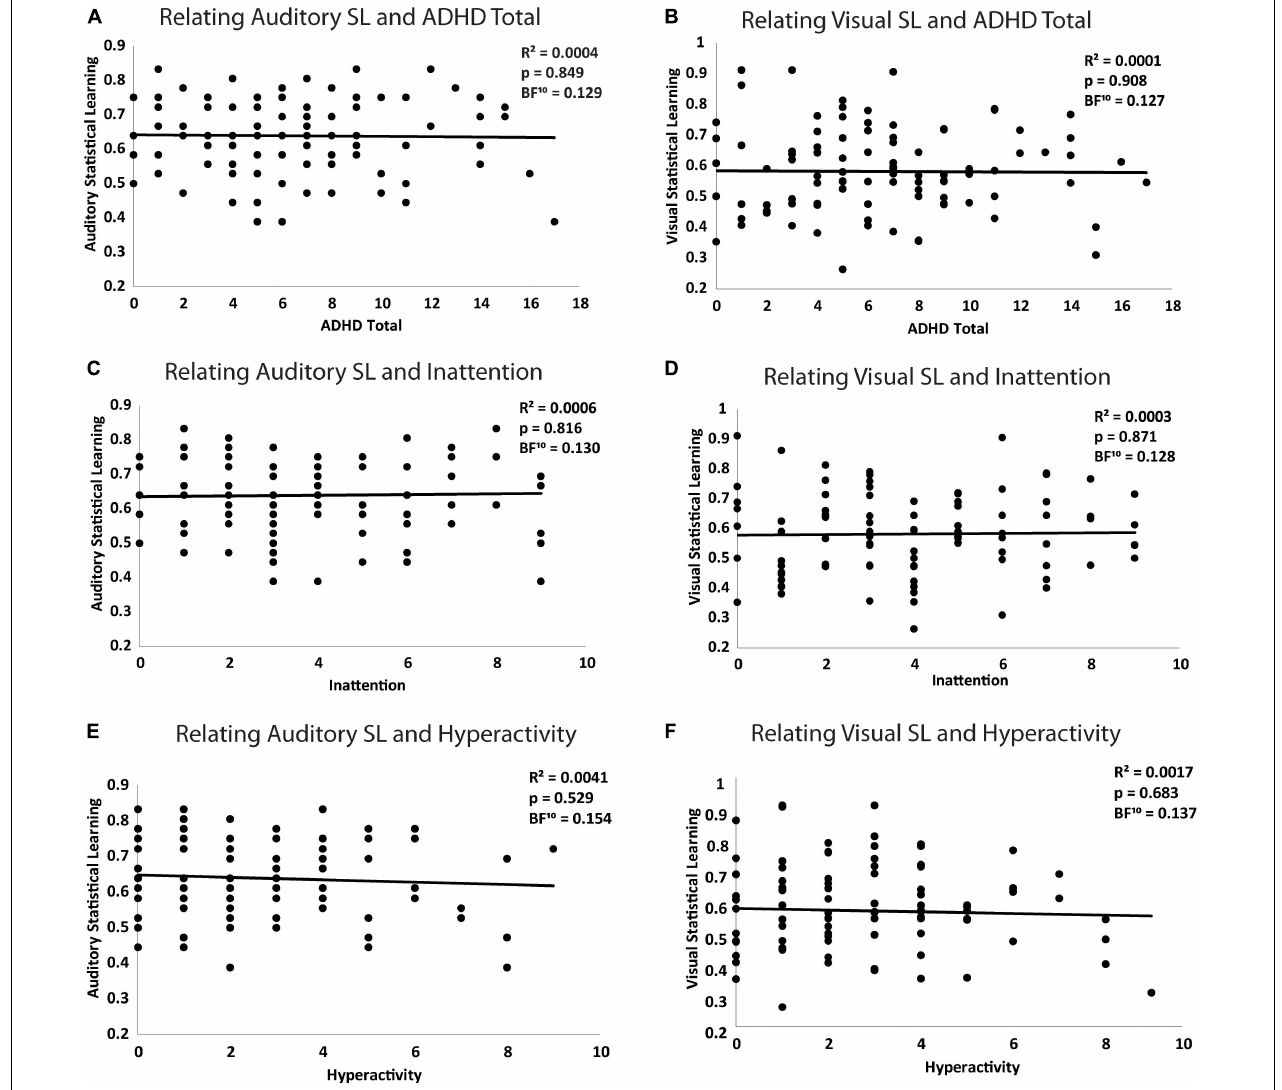
FIGURE 2 | Relating (A) auditory statistical learning and total ADHD symptomatology (B) visual statistical learning and total ADHD symptomatology (C) auditory statistical learning and inattention (D) visual statistical learning and inattention (E) auditory statistical learning and hyperactivity (F) visual statistical learning and hyperactivity where total ADHD symptomatology, inattention, and hyperactivity were all assessed using the ASRS.